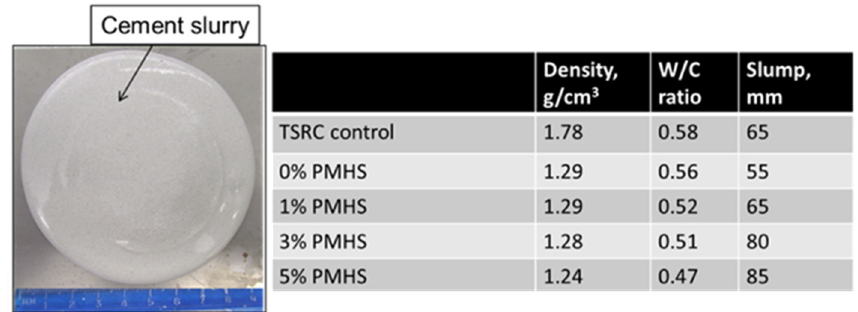
Figure 15. Photograph of cement slurry with 5%-PMHS-treated FCS and a table with slurry properties at different PMHS concentrations used to treat FCS.